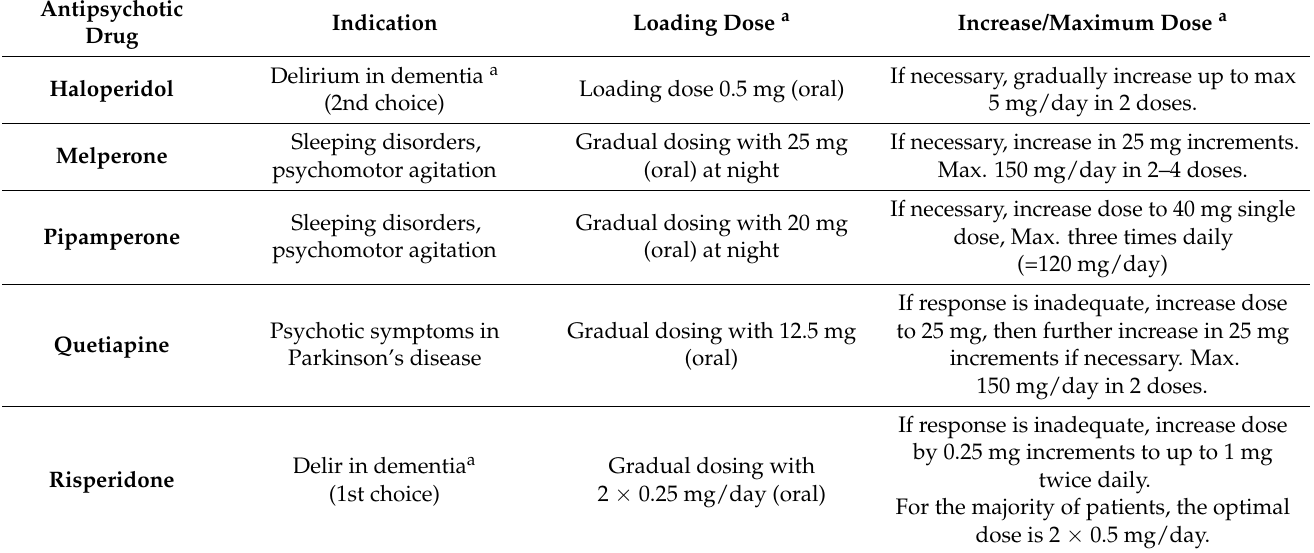
Table 3. Standardized dosing regimens of the most commonly used antipsychotics in the study